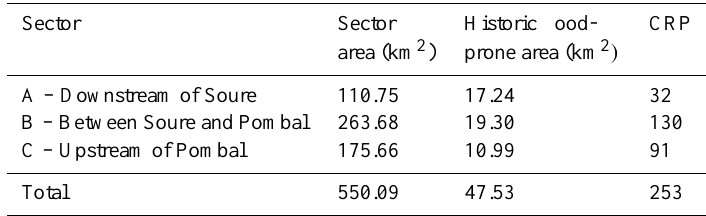
Table 5. Flood-prone areas and number of critical runoff points (CRPs) in the Arunca basin.